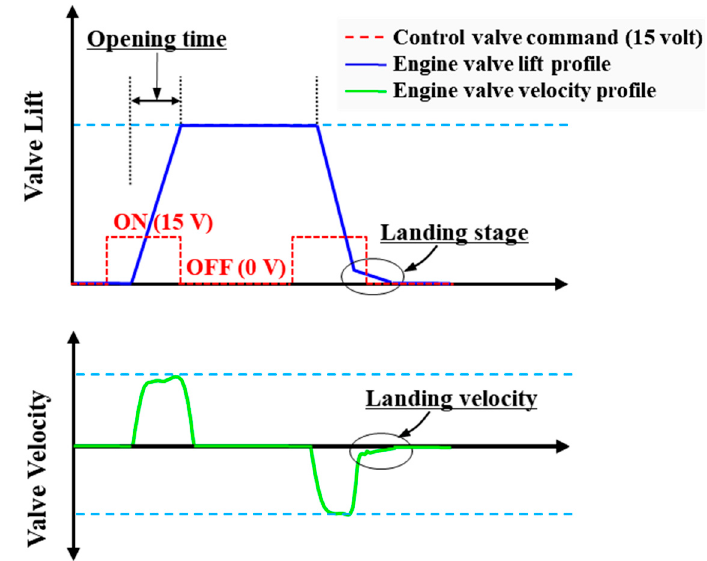
Figure 1. Scheme of the engine valve’s open and close operation.